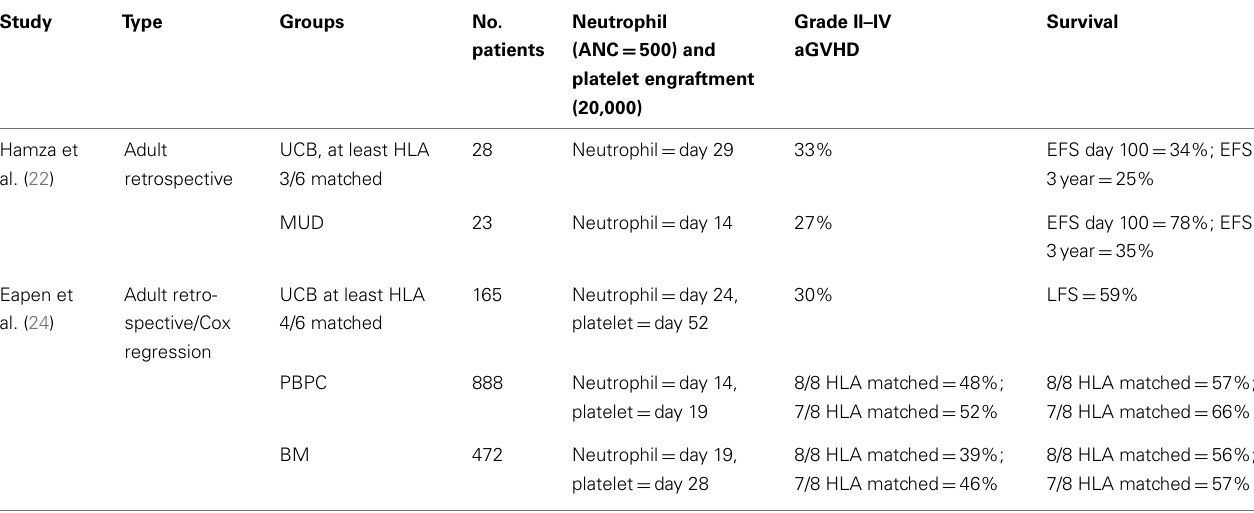
Table 2 | Comparison of graft sources.